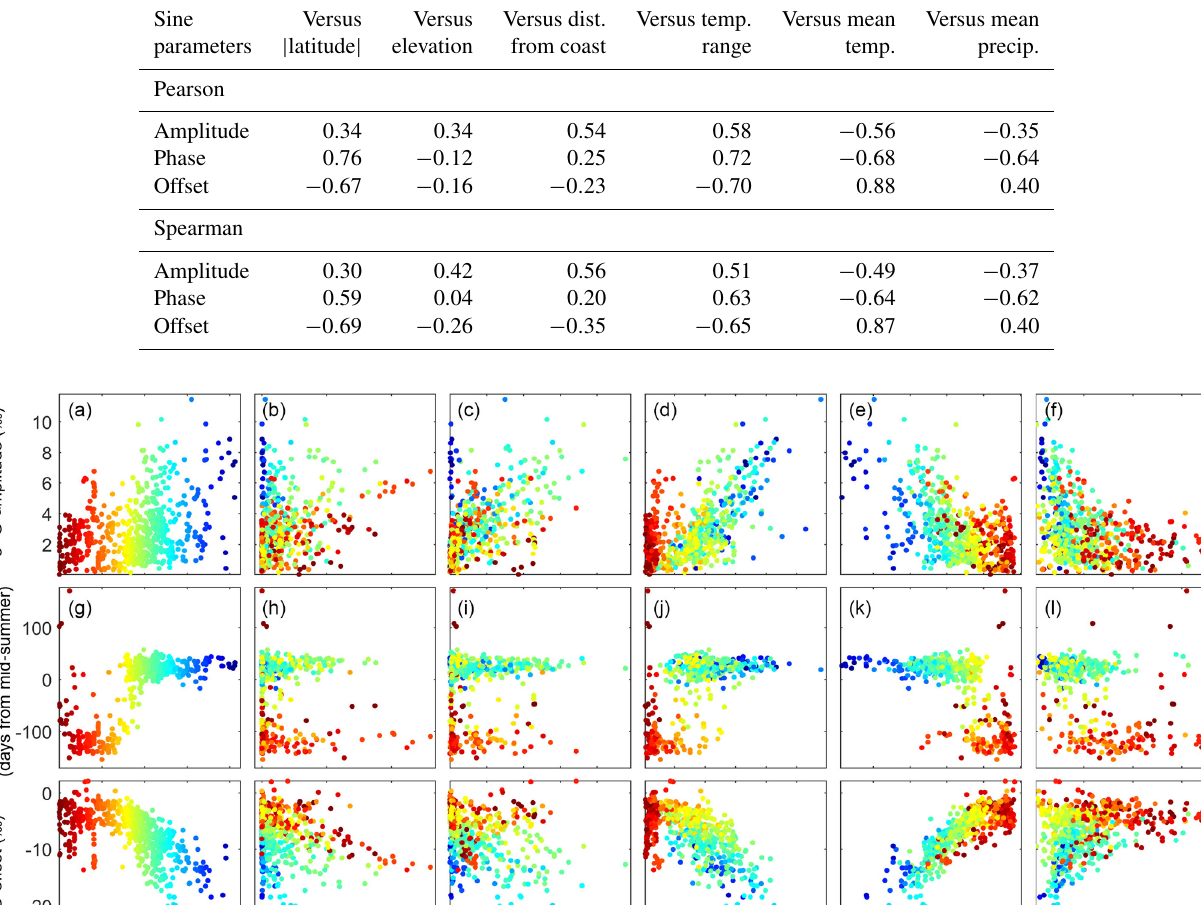
Table 1. Pearson and Spearman correlation coefficients of sine parameters versus site characteristics.